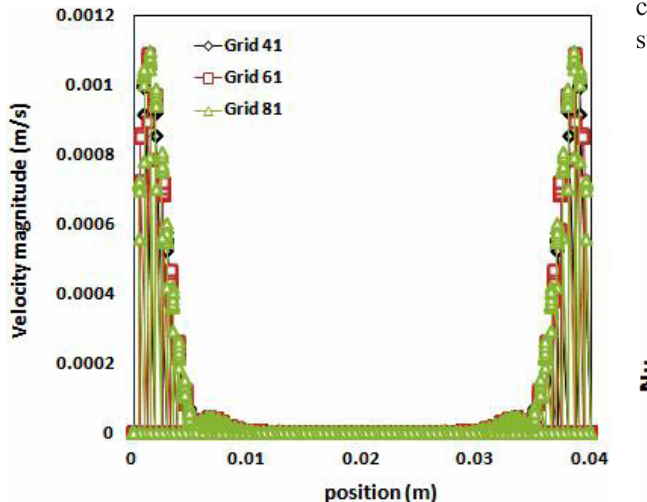
Fig. 2. Velocity magnitude at middle enclosure for showing grid independent